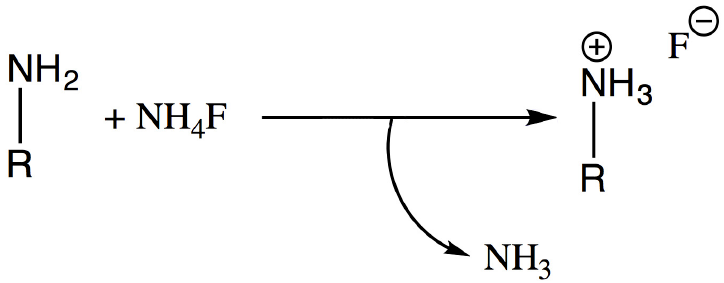
Figure 3. Reaction of ammonium fluoride with amine-containing polymers.